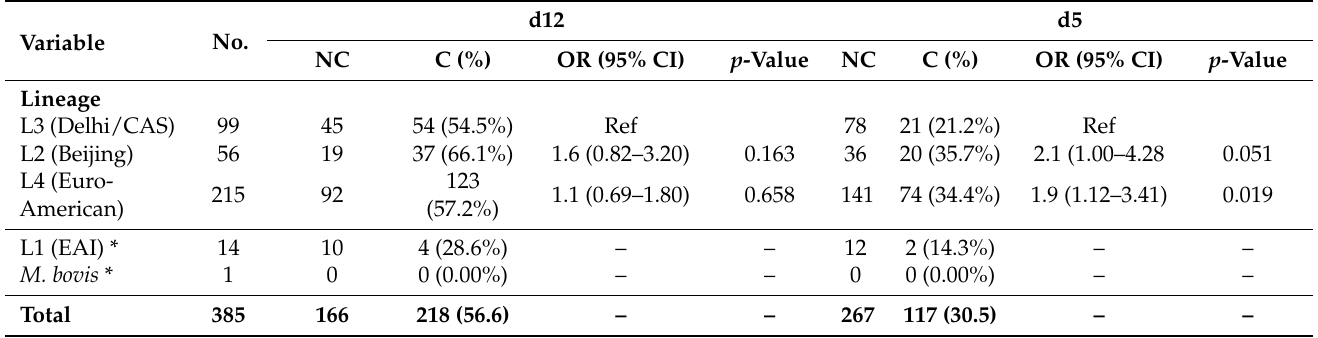
Table 4. Comparison of the proportions of clustered and not clustered strains across the detected MTBC phylogenetic lineages by using logistic regression in Nairobi, Kenya